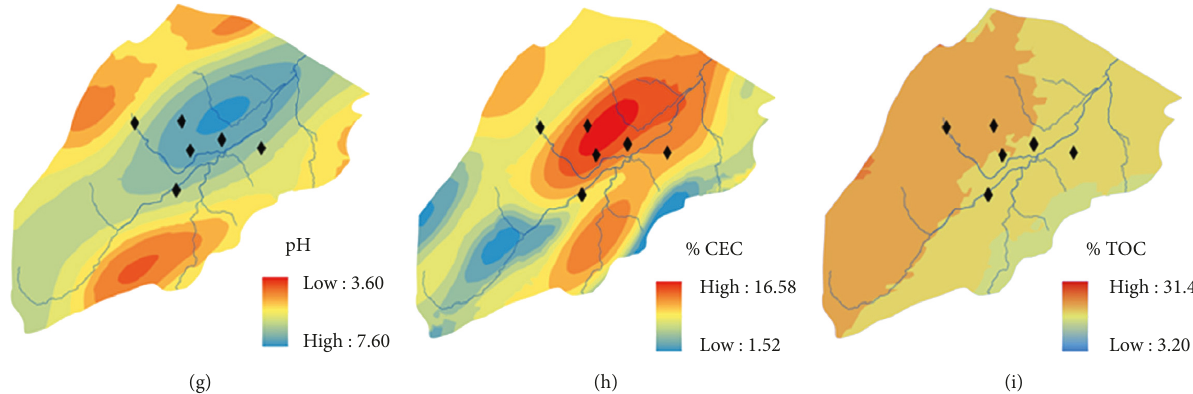
Figure 3: Ordinary kriging interpolation maps of soil physical and chemical properties: (a) elevation; (b–d) grain size distribution of sand, silt, and clay; (e) moisture content; (f) bulk density (g) pH; (h) cation exchange capacity (CEC); and (i) total organic carbon (TOC).